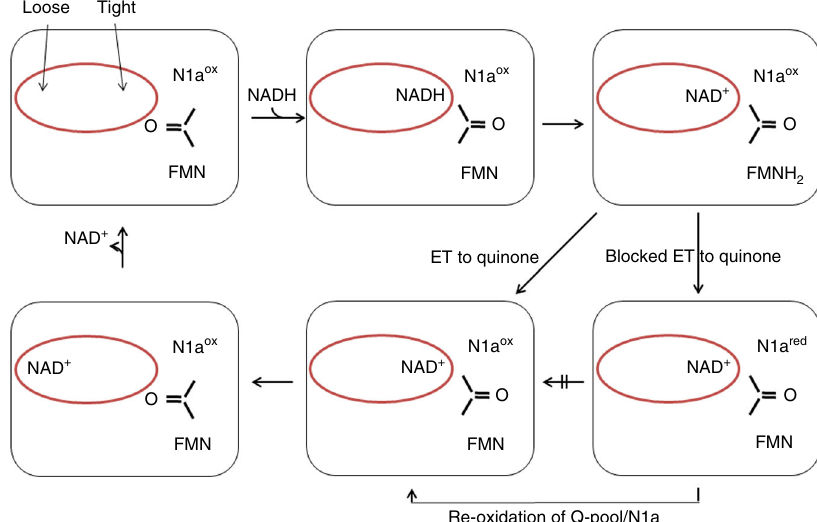
Fig. 7 NADH oxidation by complex I. The loose- and tight-binding sites for the nicotinamide nucleotide are shown as red sphere, the redox state of the Fe – S cluster N1a and the FMN is indicated, as well as the position of the C = O group of the peptide bond between E95 F and S96 F . NADH binds to the tight position of the empty binding site pushing the C = O group towards N1a. Hydride transfer leads to formation of NAD + in the tight position and of FMNH 2 . Electron transfer (ET) from FMNH 2 to the substrate quinone via the chain of Fe – S clusters leads to the re-oxidation of FMN and the fl ip of the peptide bond squeezing the NAD + into the loose position from which it easily dissociates to enable binding of the next NADH. In case that the electrons cannot escape from the complex, e.g., in the presence of a mostly reduced quinone pool, electrons from FMNH 2 are kept inside the complex leading to a reduction of N1a 21 . Reduction of N1a prevents the fl ip of the C = O group resulting in NAD + bound to the tight position from which it cannot dissociate. This